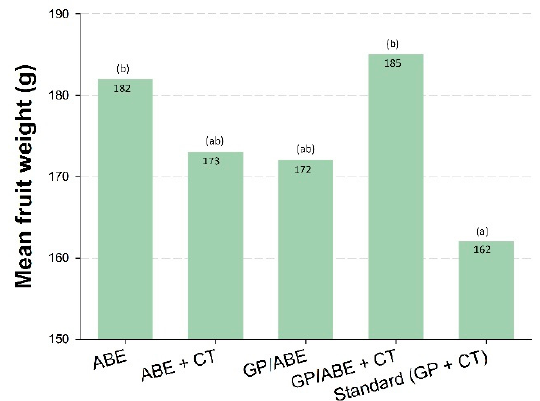
Figure 4. Effect of artificial bud extinction (ABE), pruning level and chemical thinning (CT) on mean fruit weight of ‘Buckeye Gala’. Letters above bars indicate mean separation at p = 0.05.